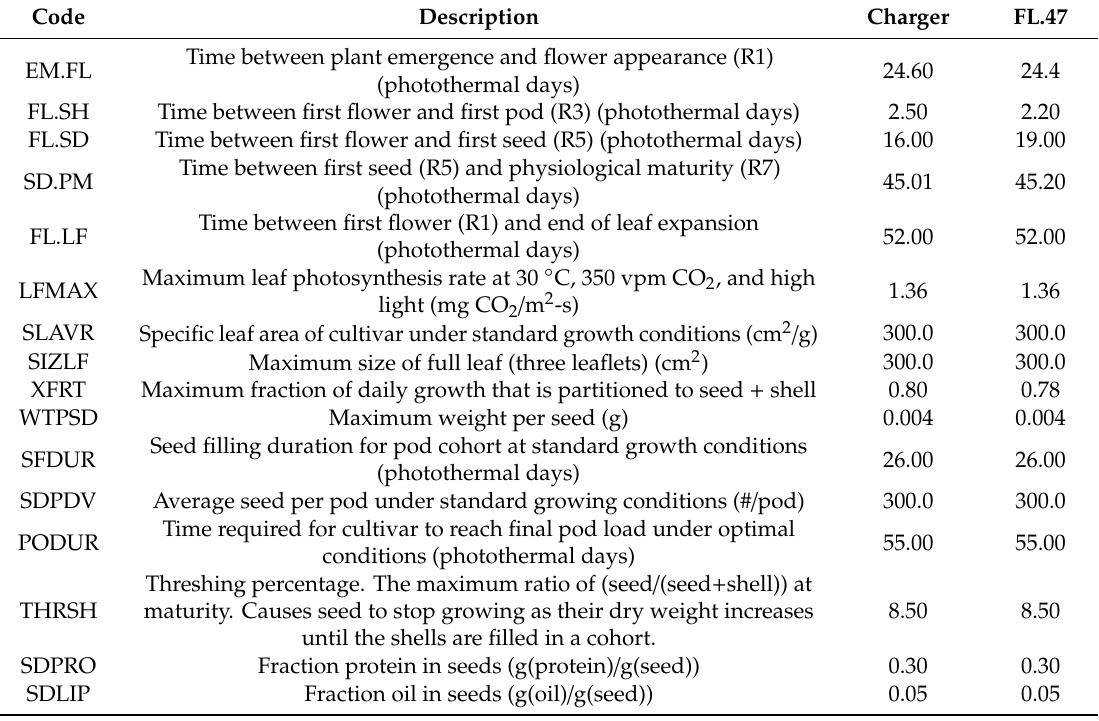
Table 1. Genetic coe ffi cients of tomato (var. Charger) calibrated in DSSAT (Decision Support System for Agricultural Transfer) against a previously calibrated FL 47 tomato cultivar.